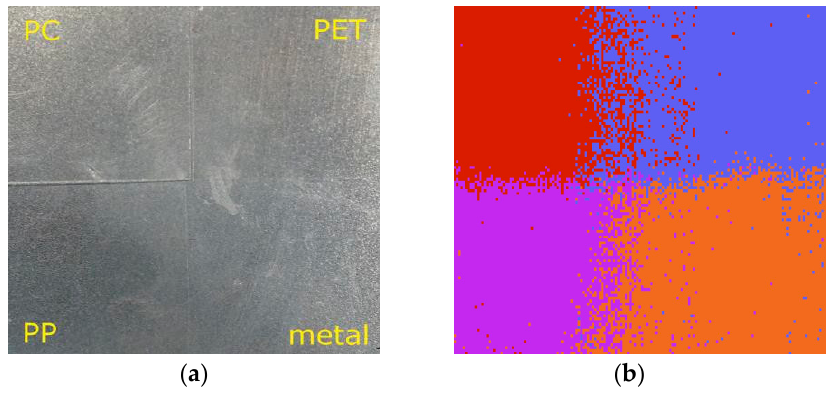
Figure 3. ( a ) Visible image of the three different polymer films on a metal plate; ( b ) False-color image generated with a classification